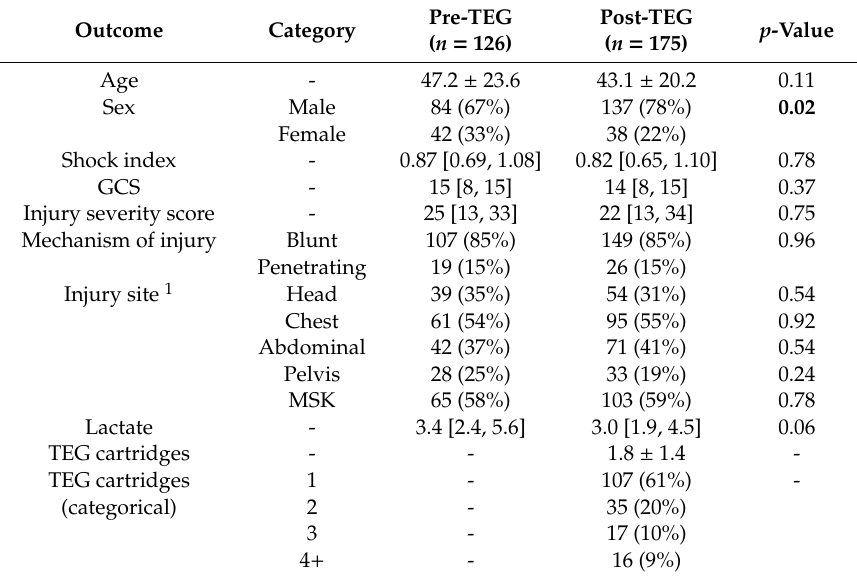
Table 1. Summary of demographics and baseline